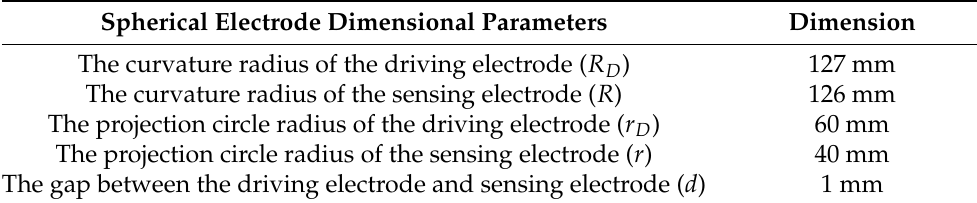
Figure 13. The spherical electrodes design and processing: ( a ) the drive electrode; ( b ) the sense elec- trode. Table 2. Dimensions of the prototype